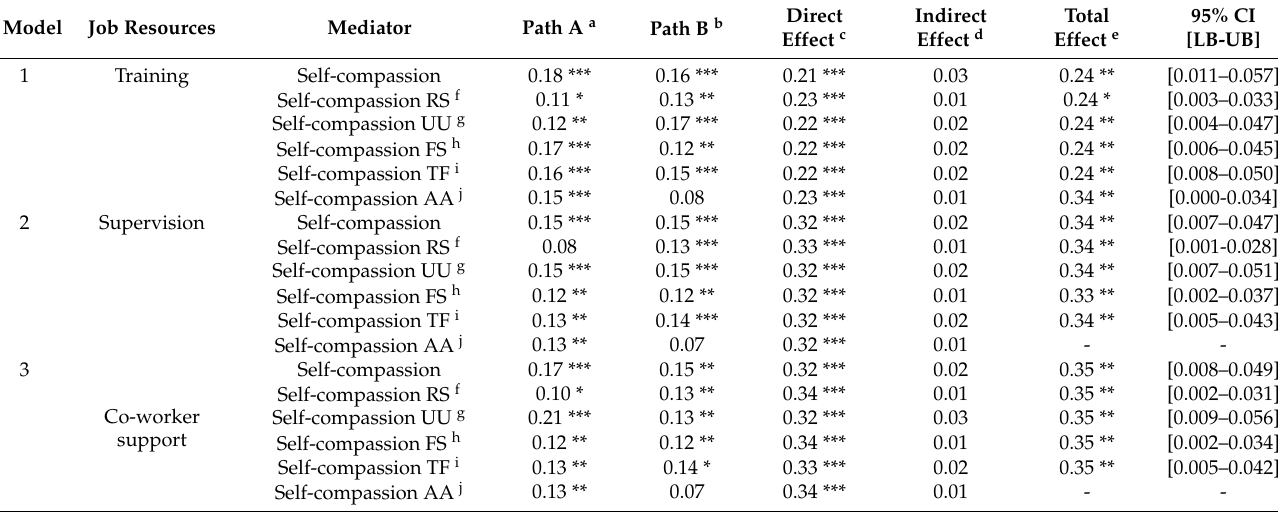
Table 3. Results of mediation models with self-compassion and subscales mediating the relationship between job resources and engagement.